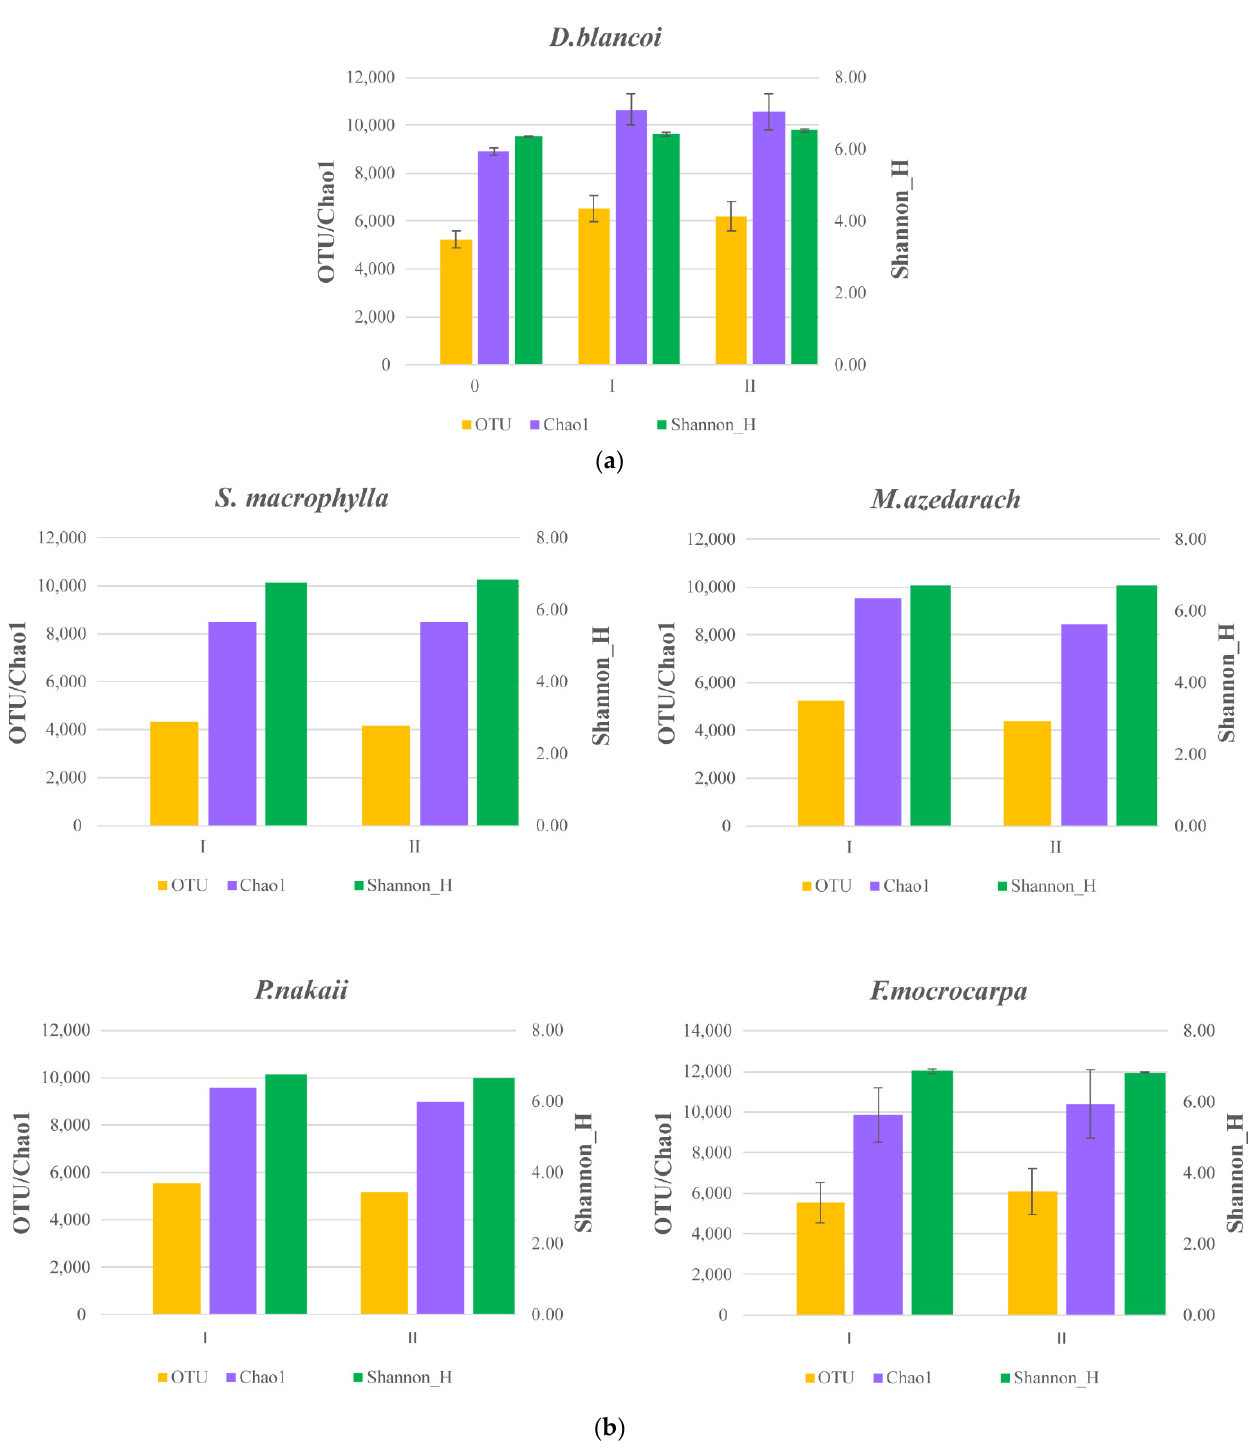
Figure 1. The change in the OTU richness, Chao1, and Shannon H ′ of the bacterial community composition associated with ( a ) D. blancoi ( n = 4) and ( b ) S. macrophylla ( n = 1), M. azedarach ( n = 1), P. nakaii ( n = 1), and F. microcarpa ( n = 2) across treatments at both sites. 0 denotes the original soil; I and II denote soil after the addition of biochar and biochar/compost in combination, respectively. Different lower-case letters denote significant difference.